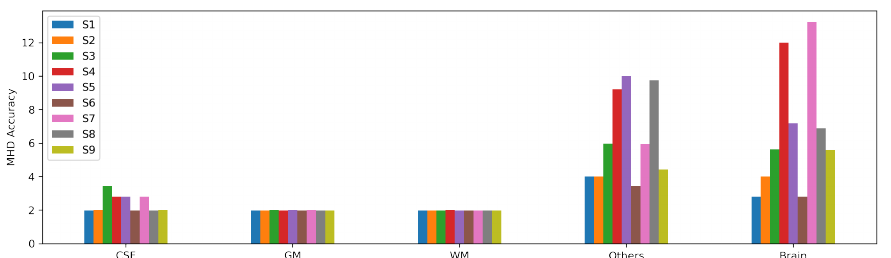
Figure 9. Accuracy per subject of our segmentation framework utilizing the 95percentile modified Hausdorff distance metric.